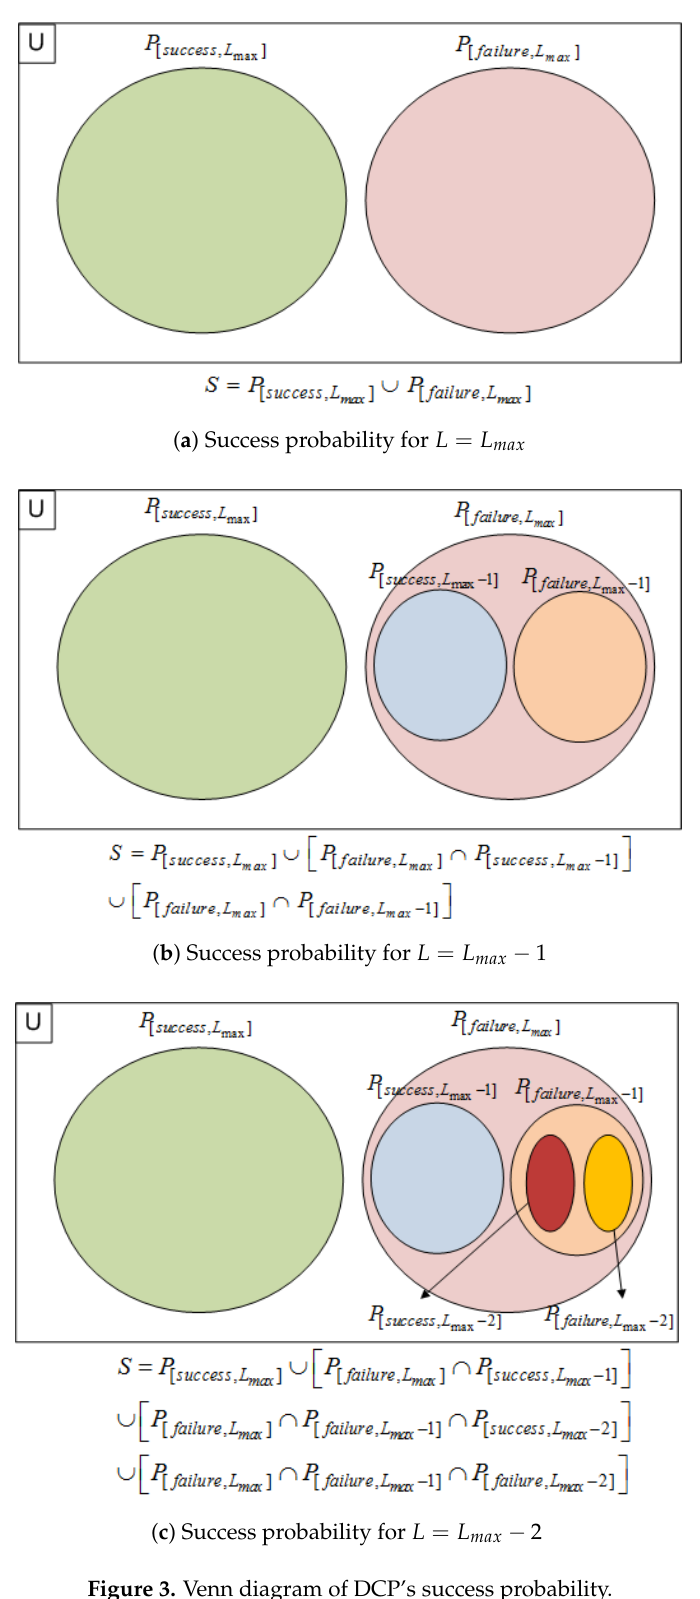
Figure 3. Venn diagram of DCP’s success